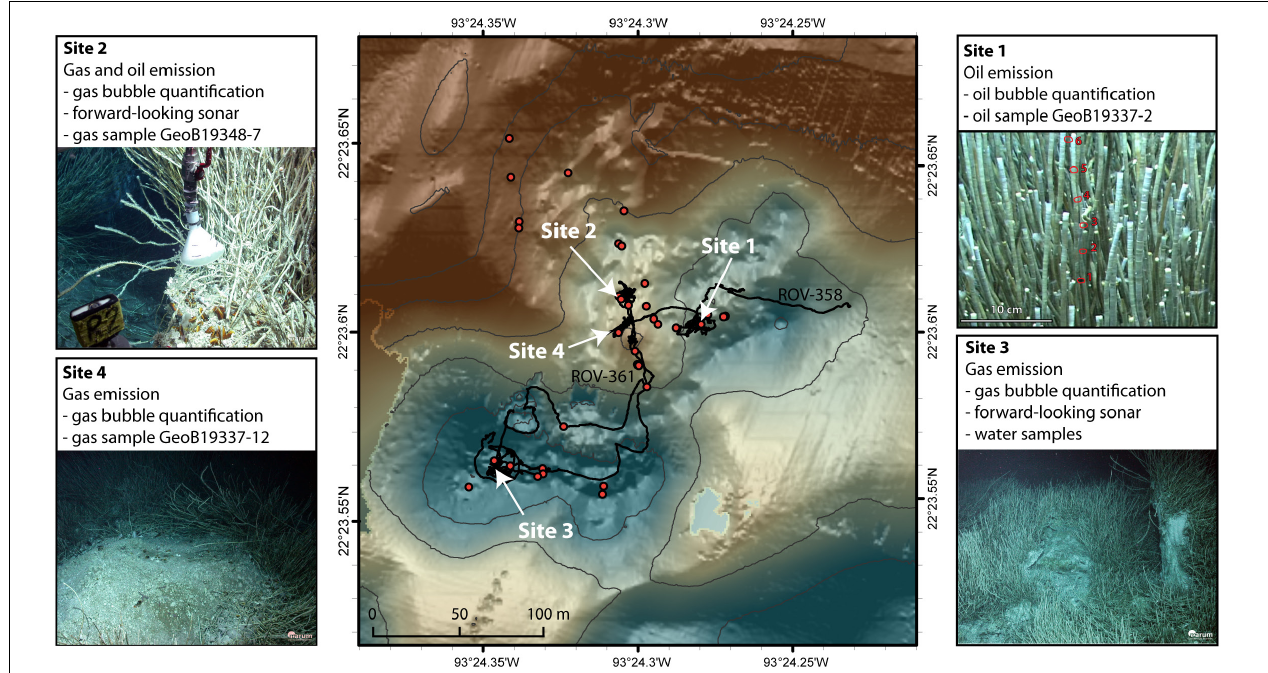
FIGURE 5 | AUV-based high-resolution bathymetric data of the main seep field at TYK and seafloor projections of the positions of 32 flares (red dots) that were detected during M114. Flares clustered in the central areas of the two depressions and at the northern flank. Track lines of the two ROV dives (black lines) crossed several flare locations. Locations of Sites 1 to 4, at which detailed investigations and gas sampling have been performed, are marked by white arrows.